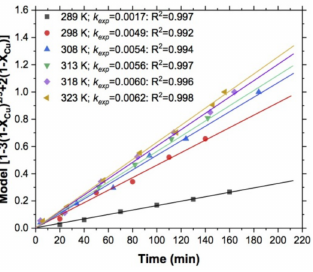
Figure 6. Determination of k exp : effect of temperature.